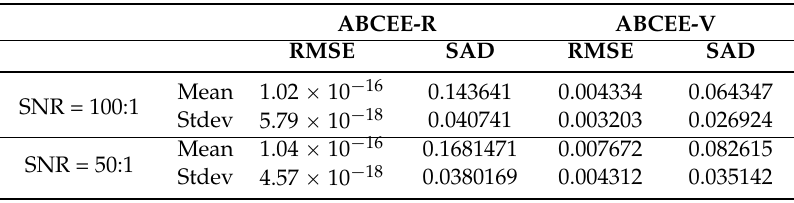
Table 4. The mean and standard deviation of 15 times run of